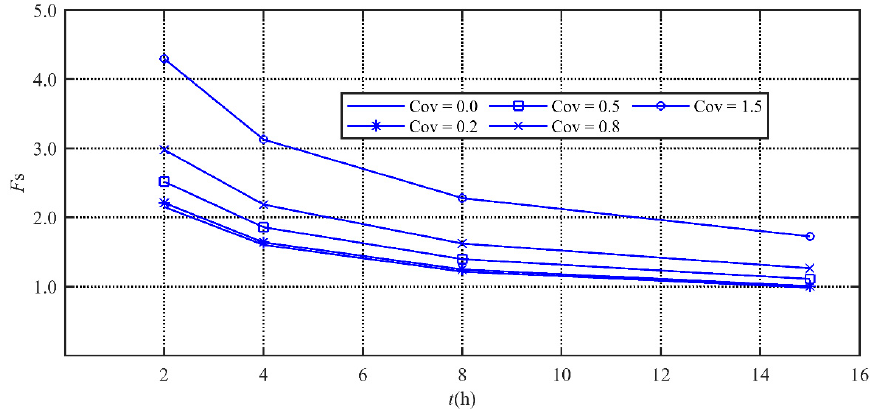
Figure 17. The variation of safety factors over time.